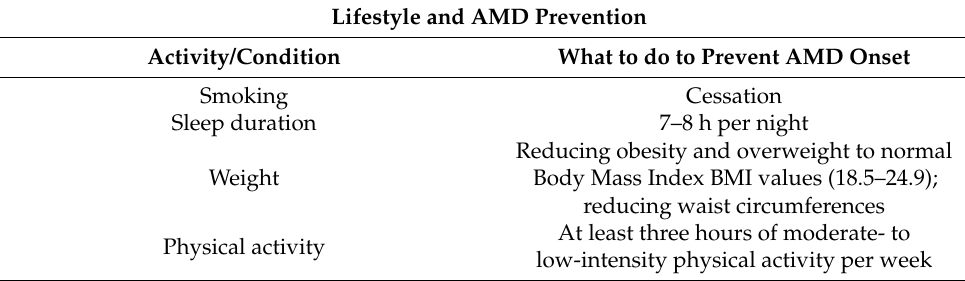
Table 4. Lifestyle modifications suggested to reduce the risk of AMD